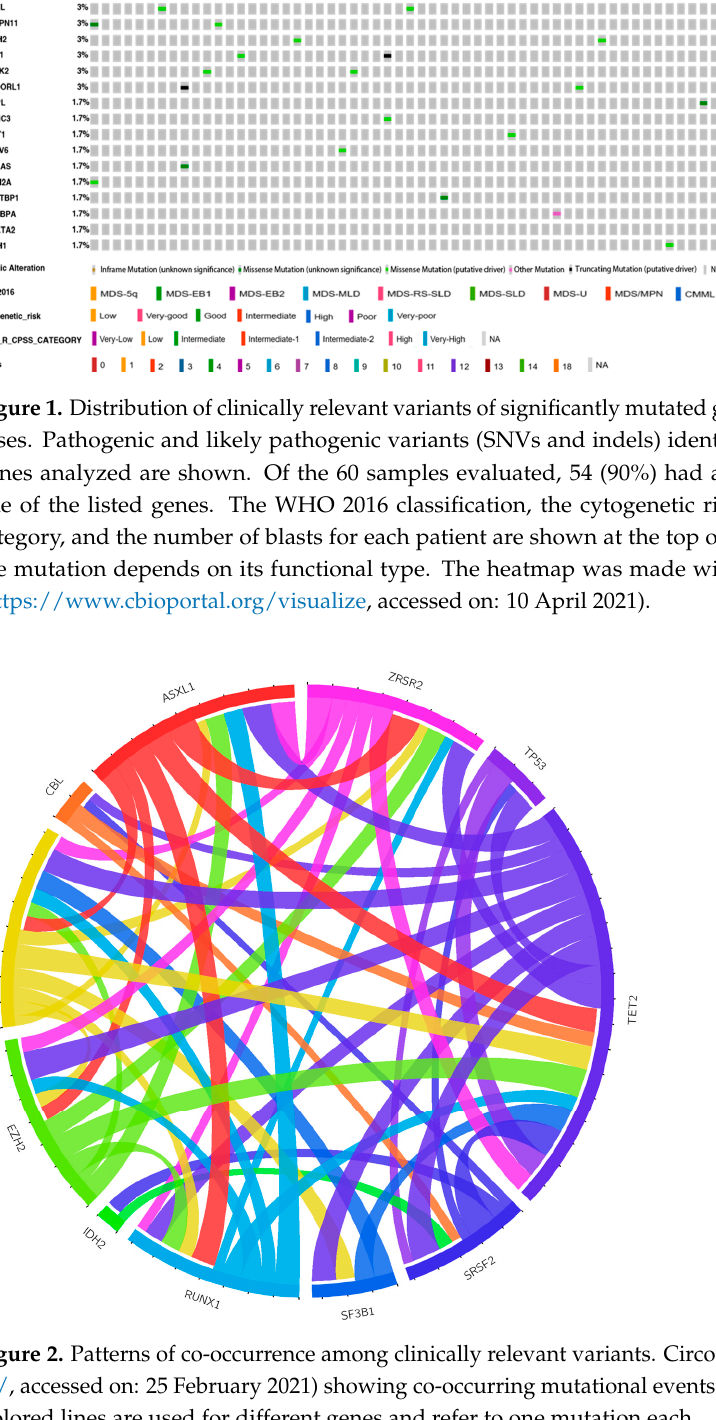
Figure 2. Patterns of co-occurrence among clinically relevant variants. Circos diagram (http://circos.ca/, accessed on: 25 February 2021) showing co-occurring mutational events within the whole cohort. Colored lines are used for different genes and refer to one mutation each.